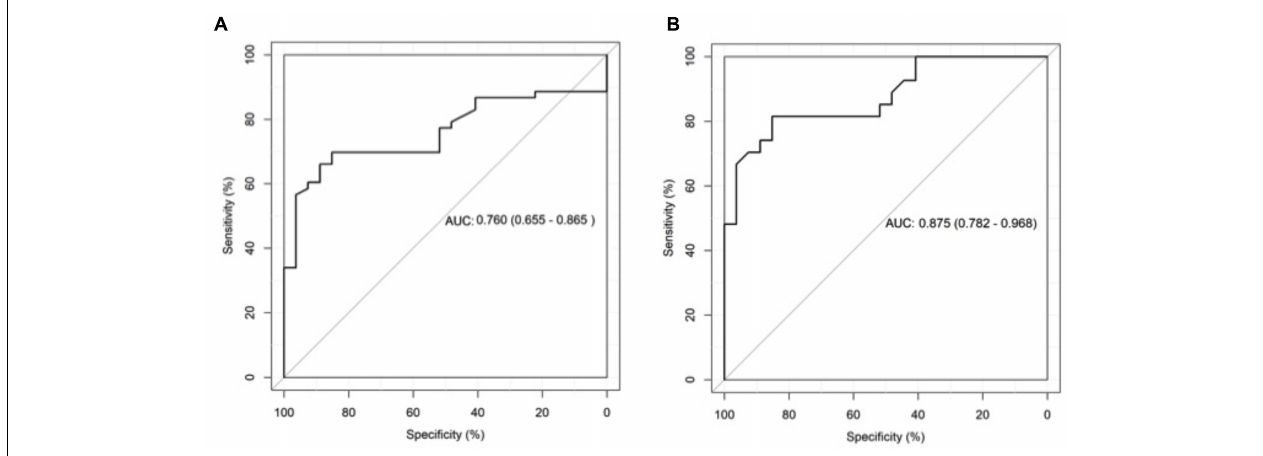
FIGURE 3 | Receiver operating characteristics (ROC) curve analysis of galactomannan test results in bronchoalveolar lavage fluid (BALF) for patients with chronic pulmonary aspergillosis (CPA) and patients with respiratory disorders without CPA (A) as well as for patients with CPA and healthy individuals (B)